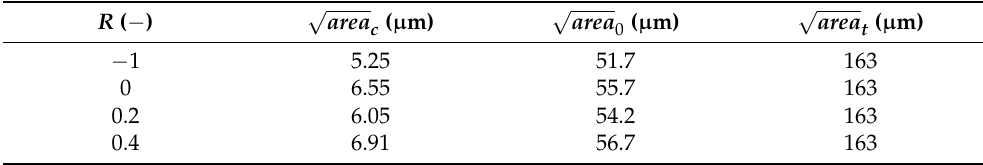
√ area Table 4. Values of the critical defect size Table 4. Values of the critical defect size √(cid:1853)(cid:1870)(cid:1857)(cid:1853) (cid:2913) , intrinsic crack with size √(cid:1853)(cid:1870)(cid:1857)(cid:1853) (cid:2868) , and transitional c , intrinsic crack with size √ area defect size t